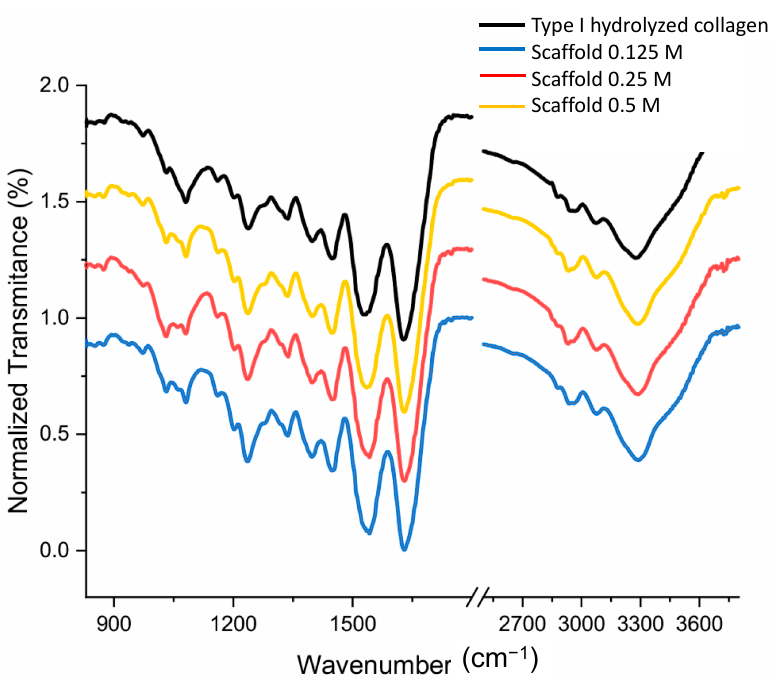
Figure 6. FT-IR spectra of prepared samples with different treatments: blue (0.125 M), red (0.25 M) and yellow (0.5 M), as well as the type I hydrolyzed collagen (dark). Representative FT-IR spectra n > 3.